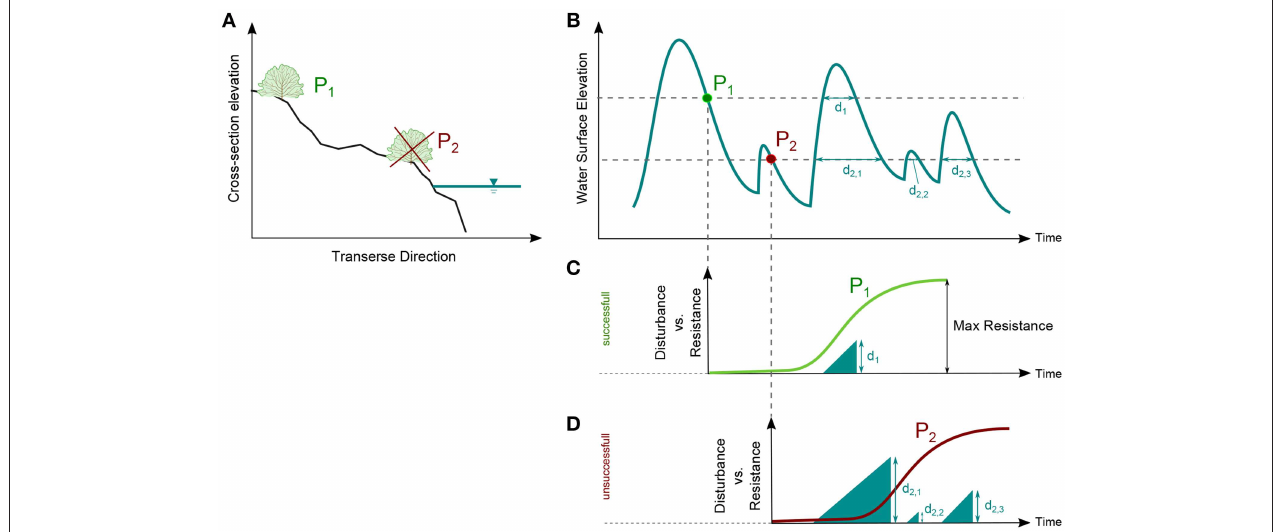
FIGURE 3 | Schematic representation of the vegetation establishment model. P1 and P2 represent seed dispersal events occurring at different elevations. Location and timing of dispersal determine the disturbance time series that seedlings have to withstand for surviving. (A) Example of a cross section with two potential sites of vegetation establishment ( P 1 and P 2 ); (B) Water surface elevation time series and dispersal events of P 1 and P 2 ; (C) Example of successful and (D) unsuccessful vegetation